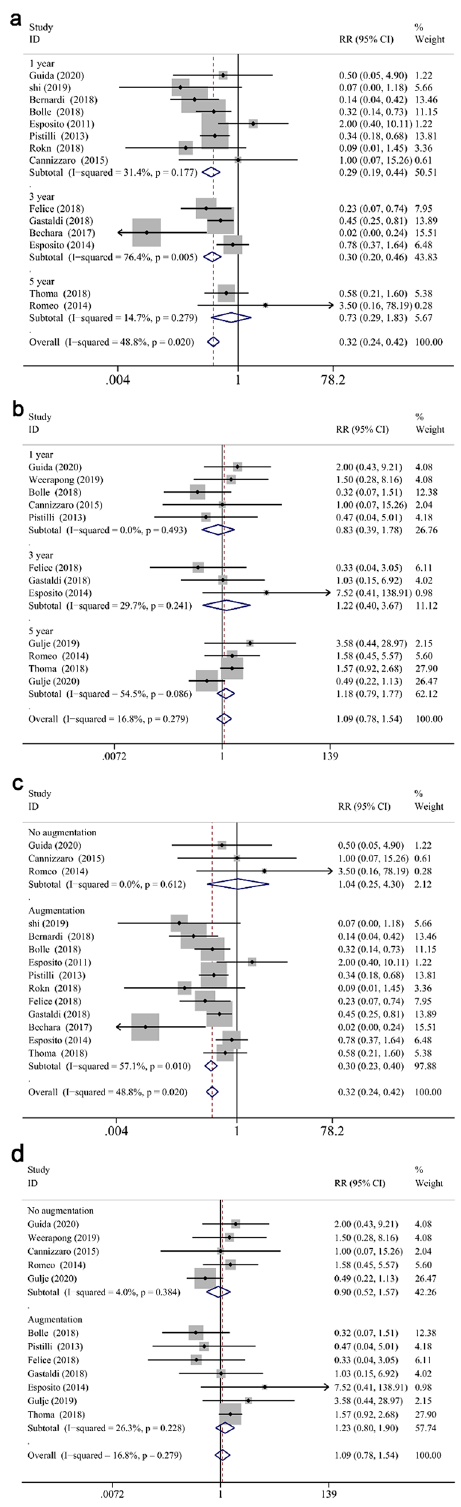
Figure 10. Forest plots (RR) of the biological ( a ) and prosthesis ( b ) complication rate comparing extra-short with longer implants group at 1-year, 3-years and 5-years follow-up. Subgroup analyses for the effects of augmentation on biological (c) and prosthesis ( d ) complication rate in both jaws. Mantel–Haenszel (MH)- weighted RR < 1 indicated a lower complication rate of extra-short implants than the longer